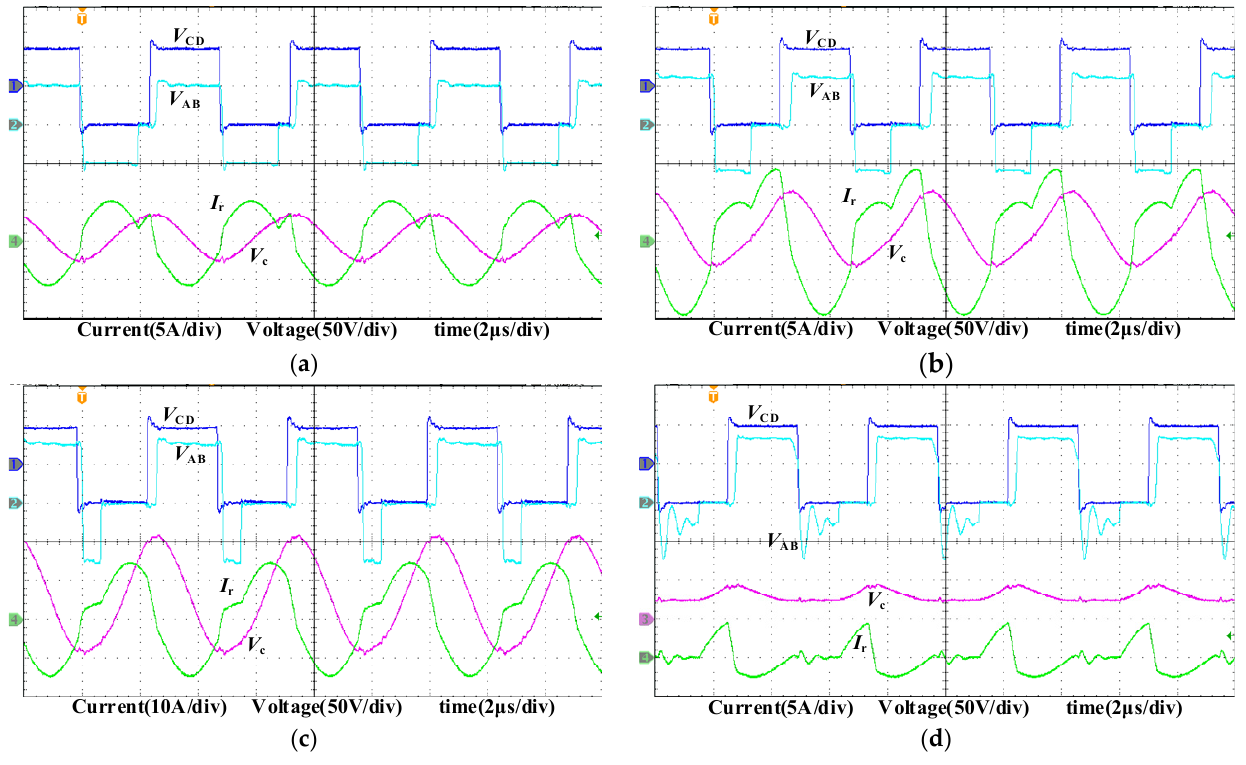
Figure 9. Experimental waveforms with different conditions. ( a ) d = 62.5% , ( b ) d = 75%, ( c ) d = 87.5%, ( d ) DCM.